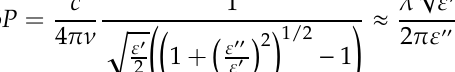
Figure 4. Laboratory test performance on improved processing of FMCW radar signal to estimate ice thickness with a 12.5 cm block of ice measured from a distance of 38.5 cm (see text).